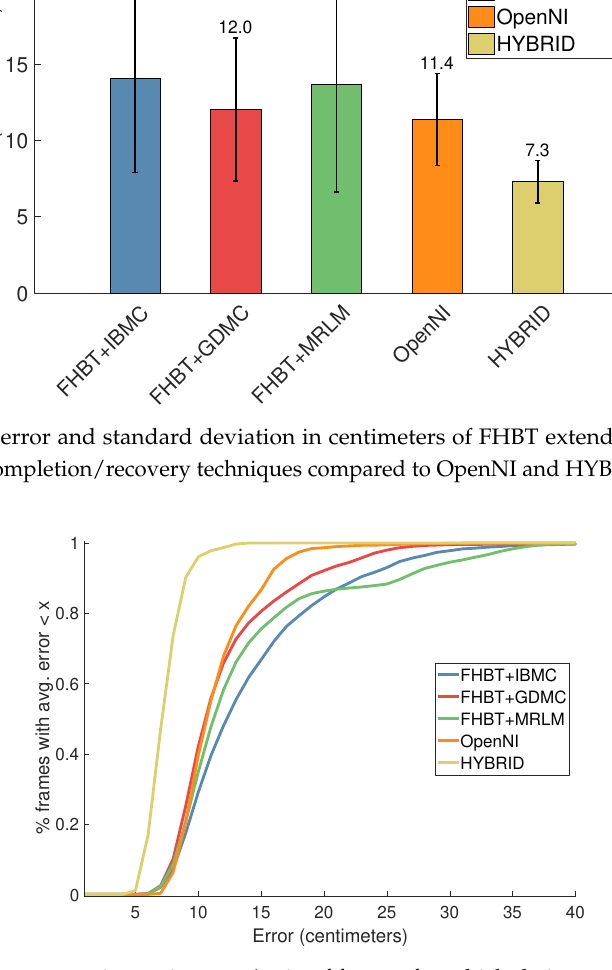
Figure 10. Average accuracy in centimeters (ratio of frames for which their average error is below a certain